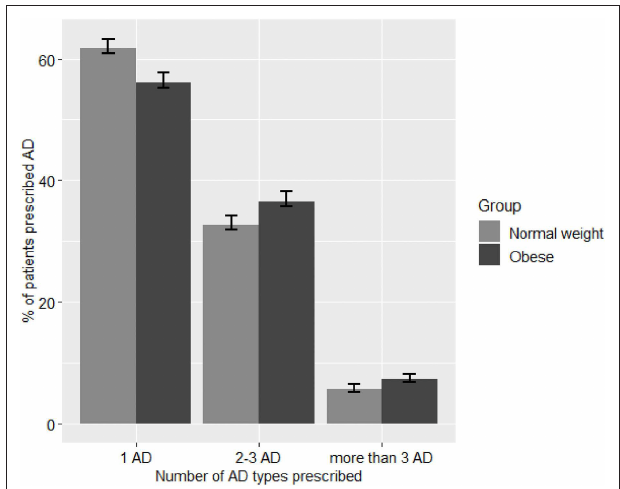
FIGURE 4 | Number of different AD types prescribed to patients with obesity and normal weight patients. AD, antidepressants medications. The bars represent % prevalence and 95% confidence intervals of prescribing 1, 2, or > 3 different types of AD for either obese or normal weight